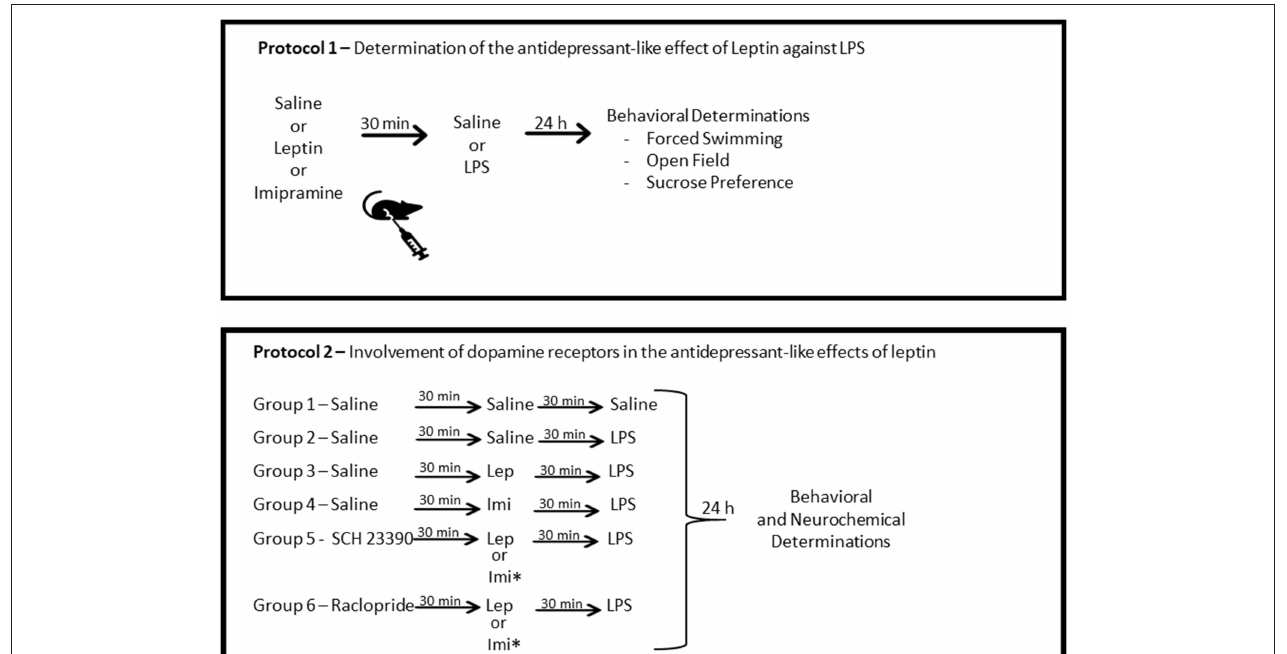
FIGURE 1 | Schematic representation of the experimental design. Protocol 1 was designed to determine the antidepressant-like effects of leptin against LPS-induced depressive-like behavior. Protocol 2 was designed to determine the participation of D1-like dopamine receptors, by the pre-administration of the antagonist SCH23390 and of D2/D3 dopamine receptors by the administration of the antagonist, raclopride. *This group was submitted only to behavioral determinations. Lep, leptin; Imi, imipramine.